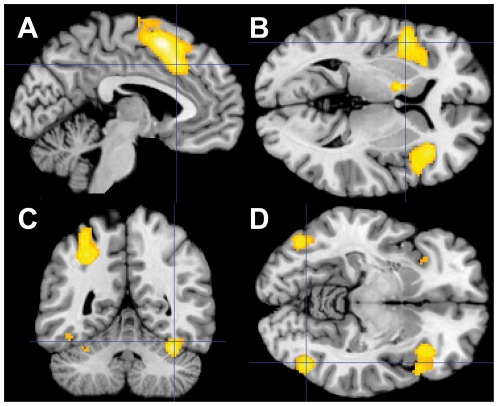
Effect of emotional conflict.(A) Involvement of left SMA and the left dACC. The intersection is in the left dACC (MNI coordinates: x = −4, y = 20, z = 38). (B) Response of the bilateral anterior insula/IFC region. The intersection is in the left anterior insula (MNI coordinates: x = −46, y = 8, z = 2). (C) Recruitment of the right fusiform face area (MNI coordinates: x = 36, y = −52, z = −22) and the left inferior parietal lobule. (D) Bilateral recruitment of the bilateral occipitotemporal visual cortex. Intersection is in the right temporal gyrus (MNI coordinates: x = 46, y = −68, z = −10). Activity is shown at p<0.05 FWE corrected with a cluster size >20 voxels.